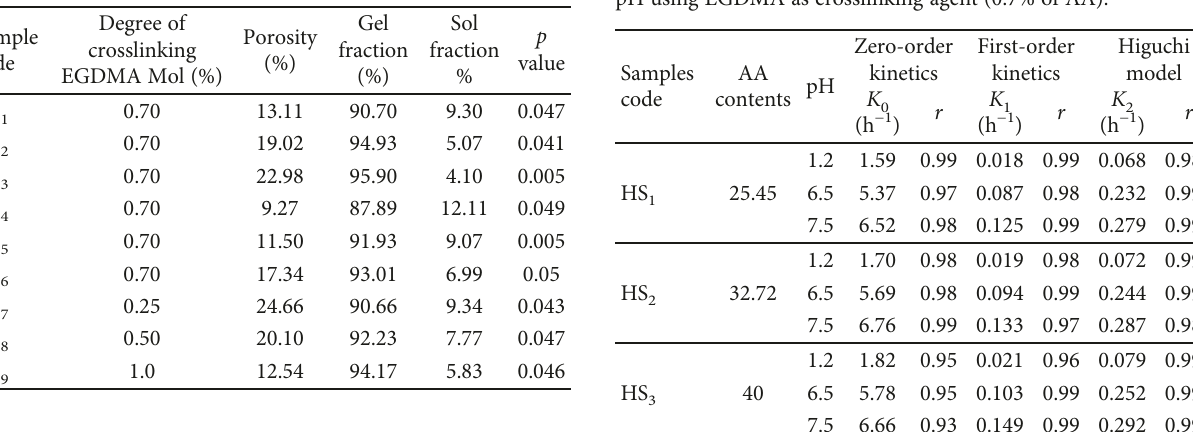
Figure 8: E ff ect of di ff erent contents on gel fraction (a) CMCS concentration, (b) EGDMA concentration, and (c) AA concentration. Table 4: Porosity and Sol-gel fraction analysis of di ff erent formulations.